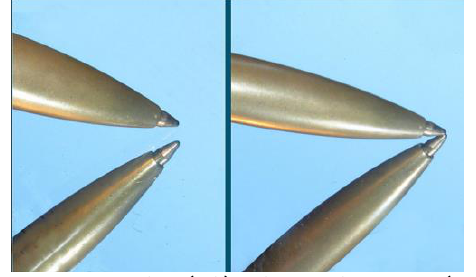
Figure 1: Back surface (left) & front surface mirror (right) (First Surface Mirror, 2018)